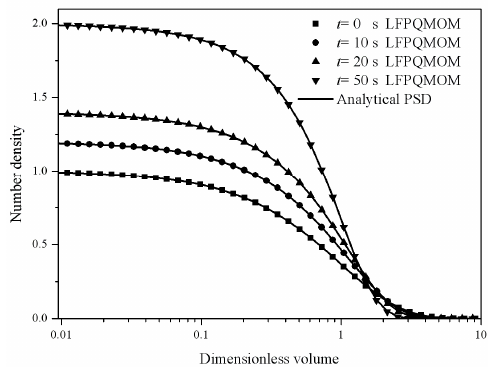
Figure 18. Particle size distribution at 0, 2, 5, and 10 s for the pure breakage process with square kernel, exponential initial PSD, and uniform daughter distribution (square: numerical PSD at 0 s; circle: numerical PSD at 10 s; up triangle: numerical PSD at 20 s; down triangle: numerical PSD at 50 s; line: analytical PSD).